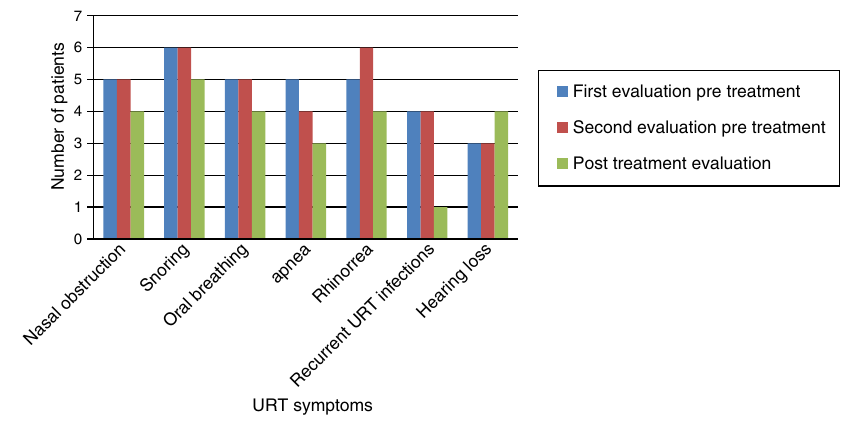
Figure 1 Otolaryngological symptoms obtained from directed anamnesis.